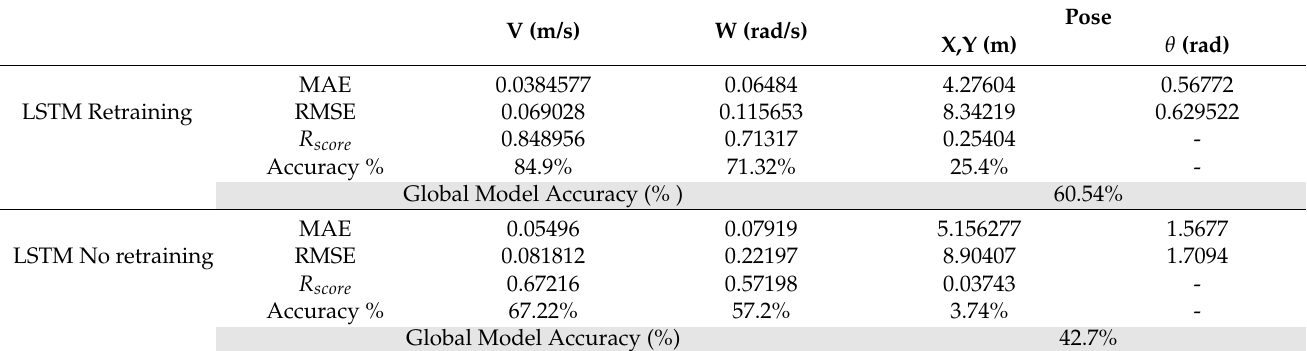
Table 2. Error values obtained by comparing the LSTM-odometry model with and without retraining considering the velodyne data as